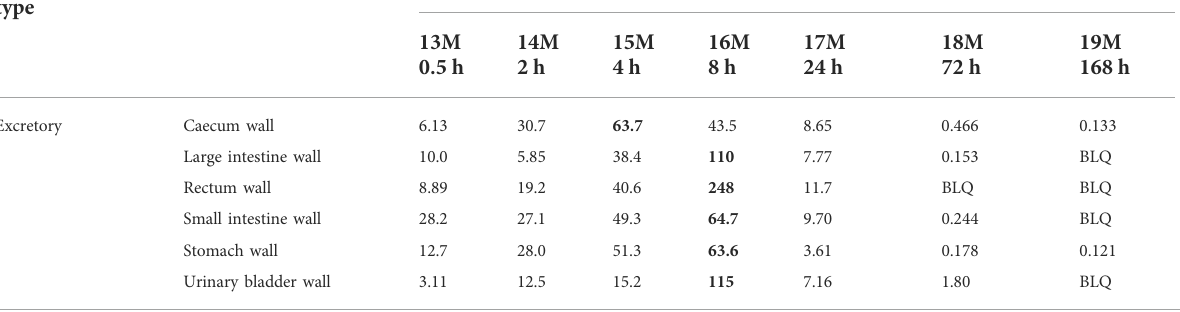
c Tissue corrected for quenching. ForallQWBAmeasurements:Valuesinboldrepresentmaximumtissueconcentrations(T max ).Upperandlowerlimitsofquanti fi cation=510and0.118